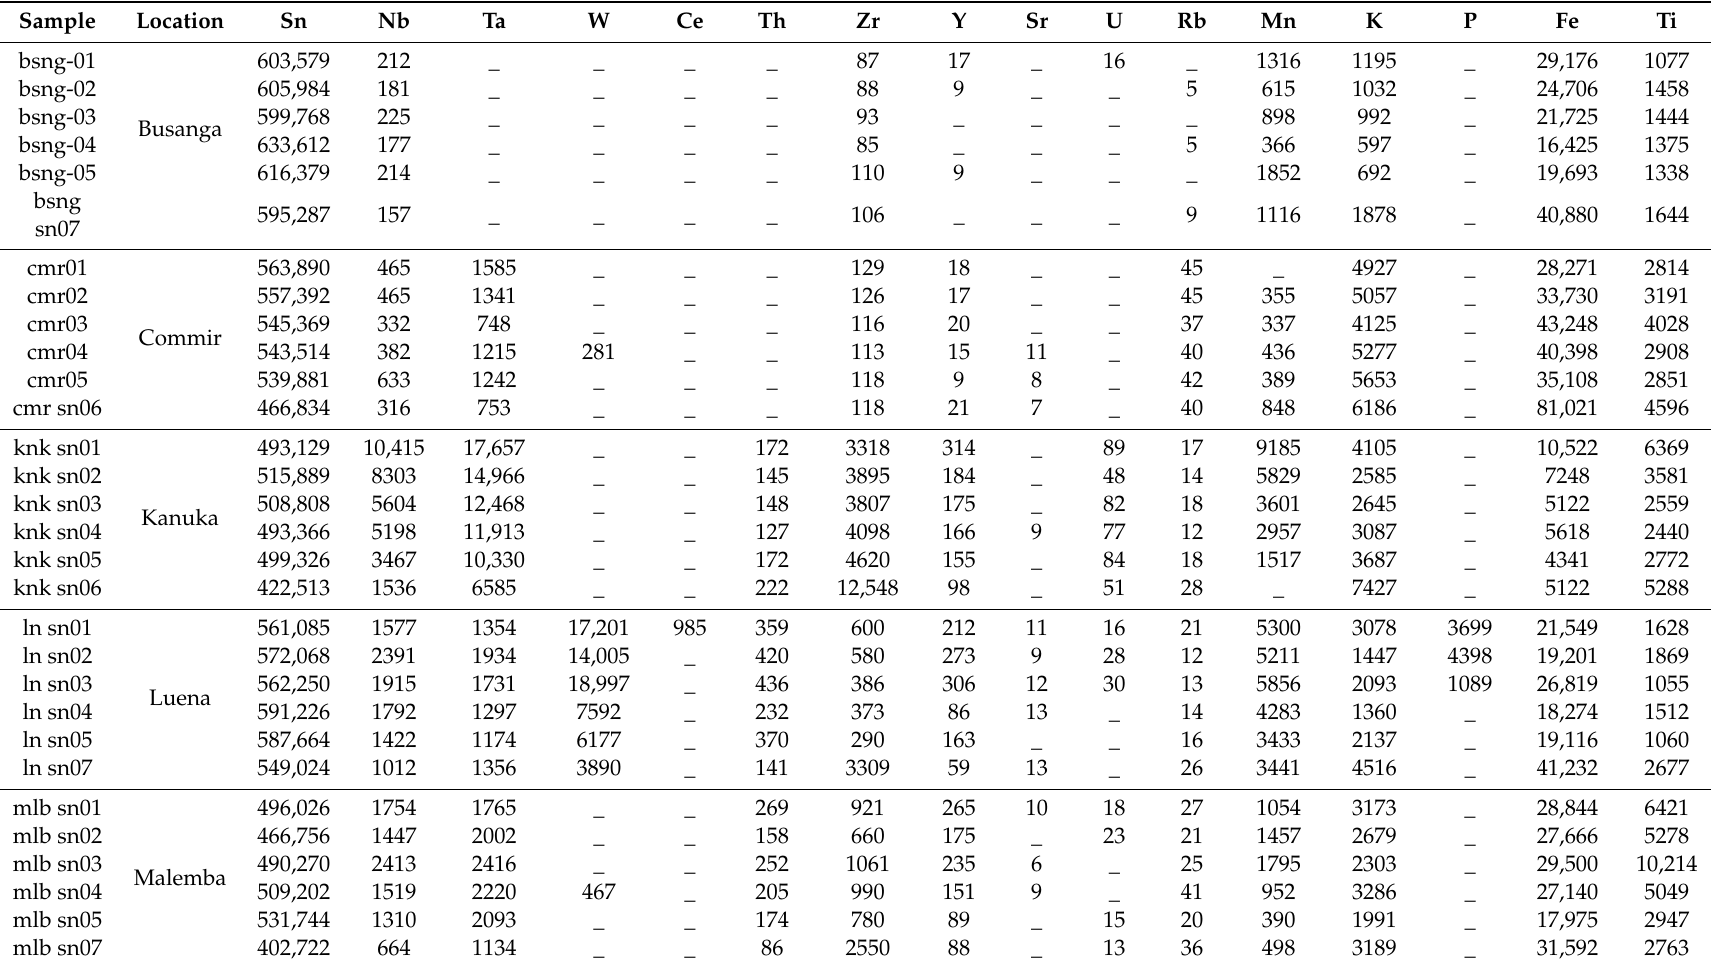
Table 4. Chemical analysis of cassiterite ore samples (in ppm). Nd, La, Ba were not detected. _Not